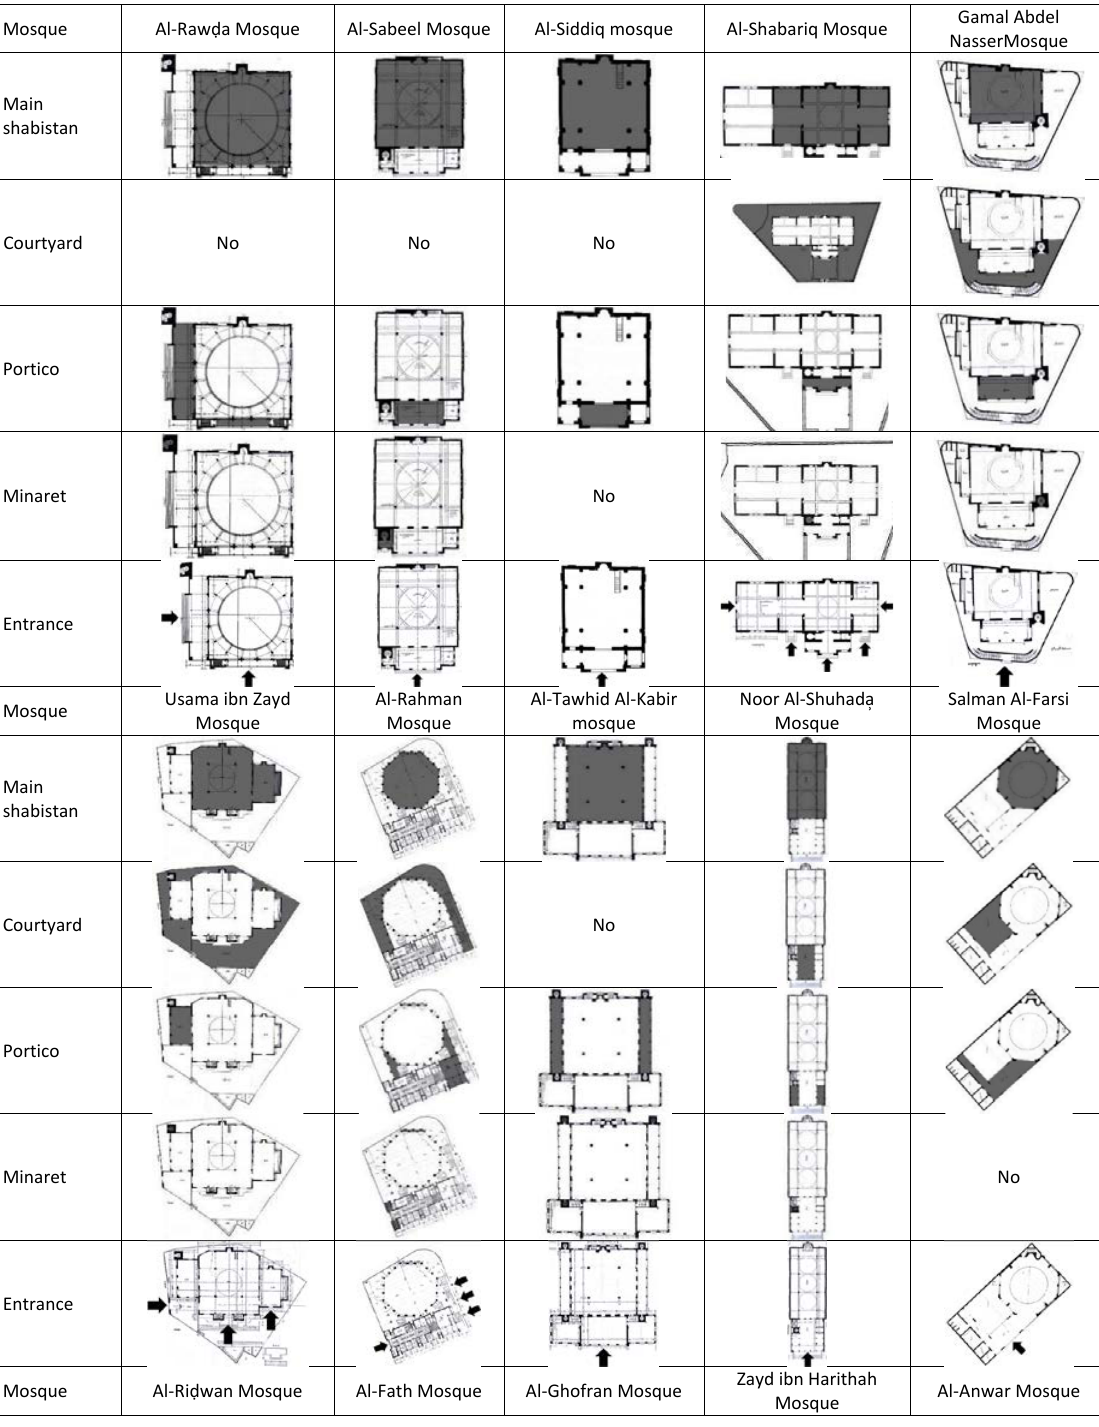
Table 4: Micro-functions of contemporary Table 4: Micro‐functions of contemporary mosques